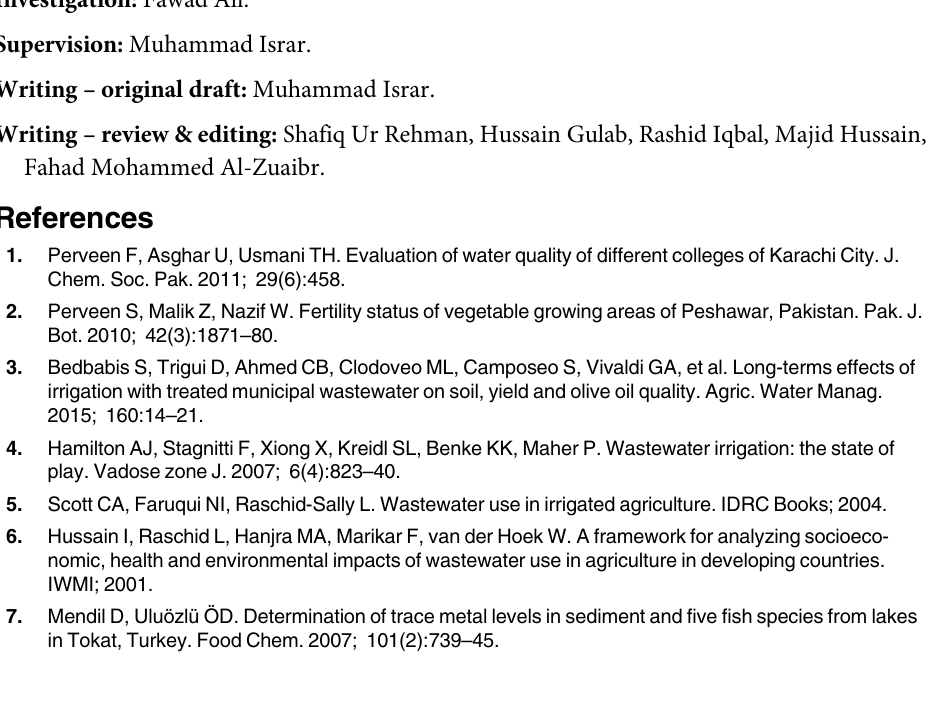
S1 Table. List of dietary vegetables used in this